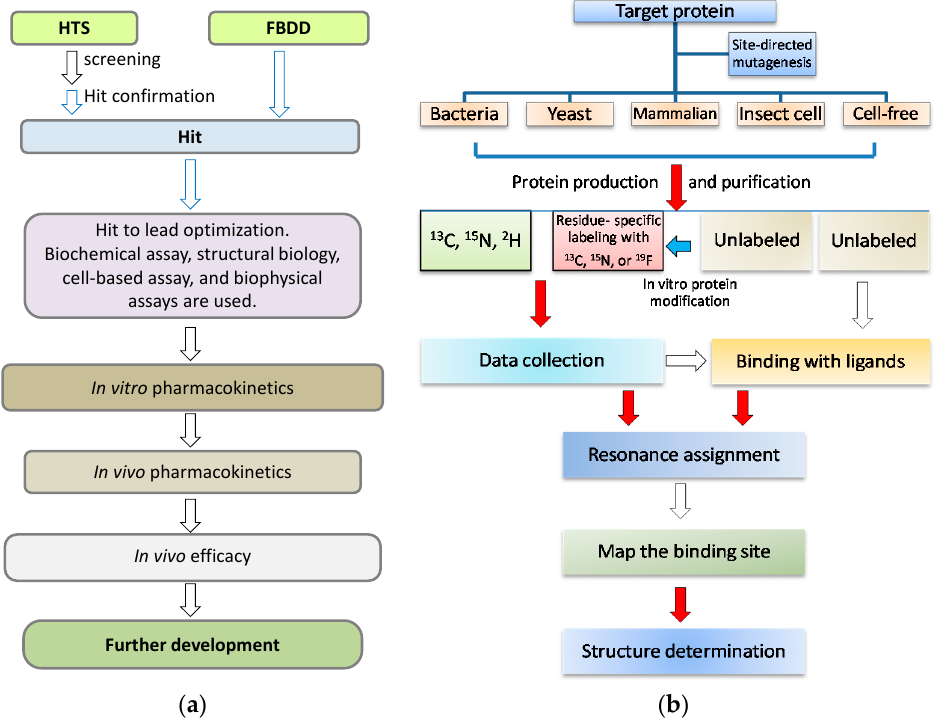
Figure 1. NMR in drug discovery. ( a ) A simplified flowchart in drug discovery process. When a target is defined, a couple of steps will be gone through in the drug discovery. NMR spectroscopy is useful and plays important roles in the early stage, which is highlighted with blue arrows; ( b ) A flowchart for the procedures in protein NMR studies. There are several challenging and time-consuming steps from target gene cloning to target-ligand complex structural determination, which include target protein purification, resonance assignment, and structure determination. The challenging steps are highlighted with red arrows.